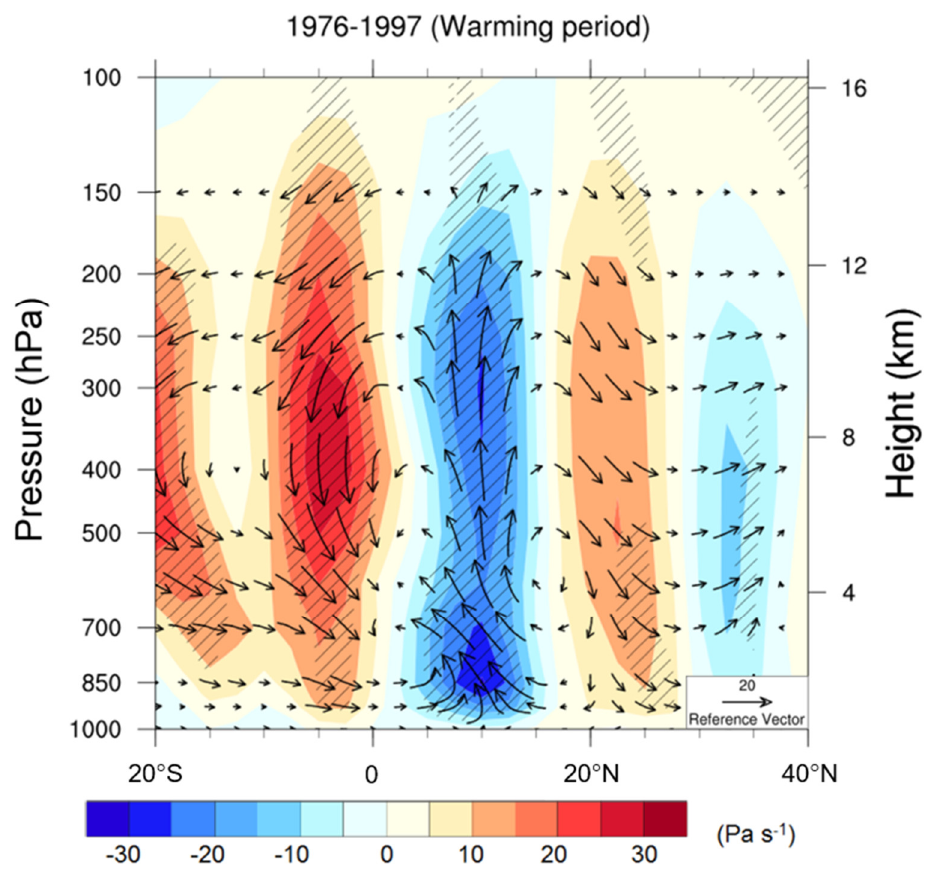
Figure 14. Latitude-pressure cross section of composite anomalies between positive and negative years of EOF2 in omega (shading, unit: Pa s −1 ) and winds (vectors), averaged over 120° E–150° E.